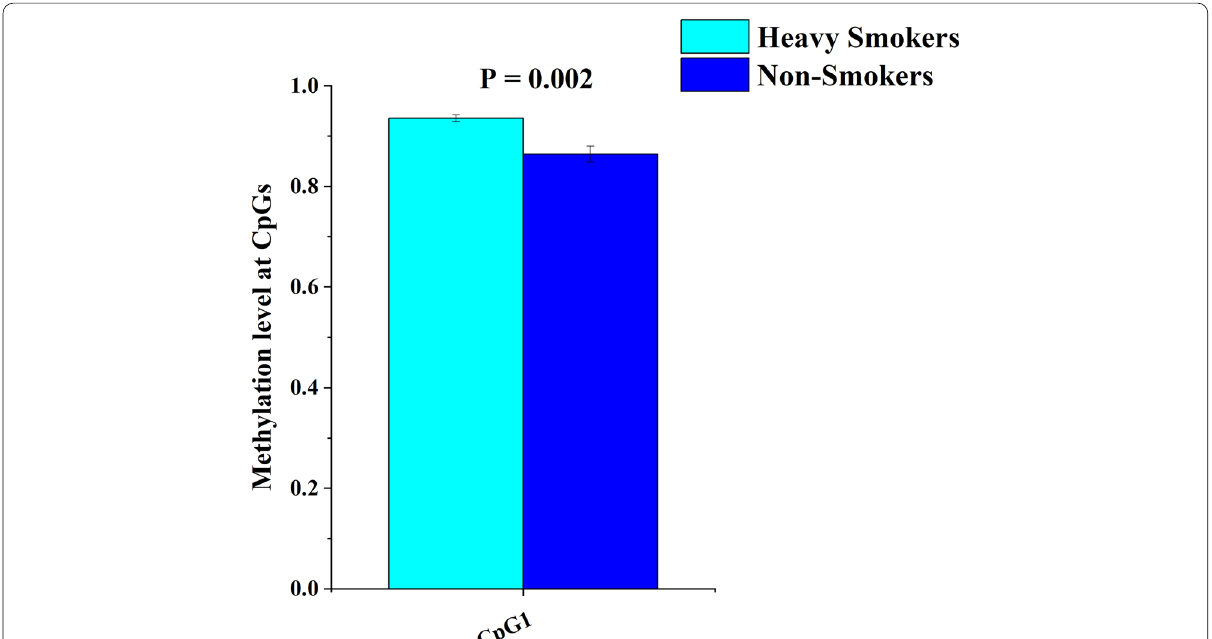
Fig. 7 Methylation level at CpGs within PDE11A gene-related amplicon in heavy smokers compared to non-smokers. P < 0.05: significant; P not